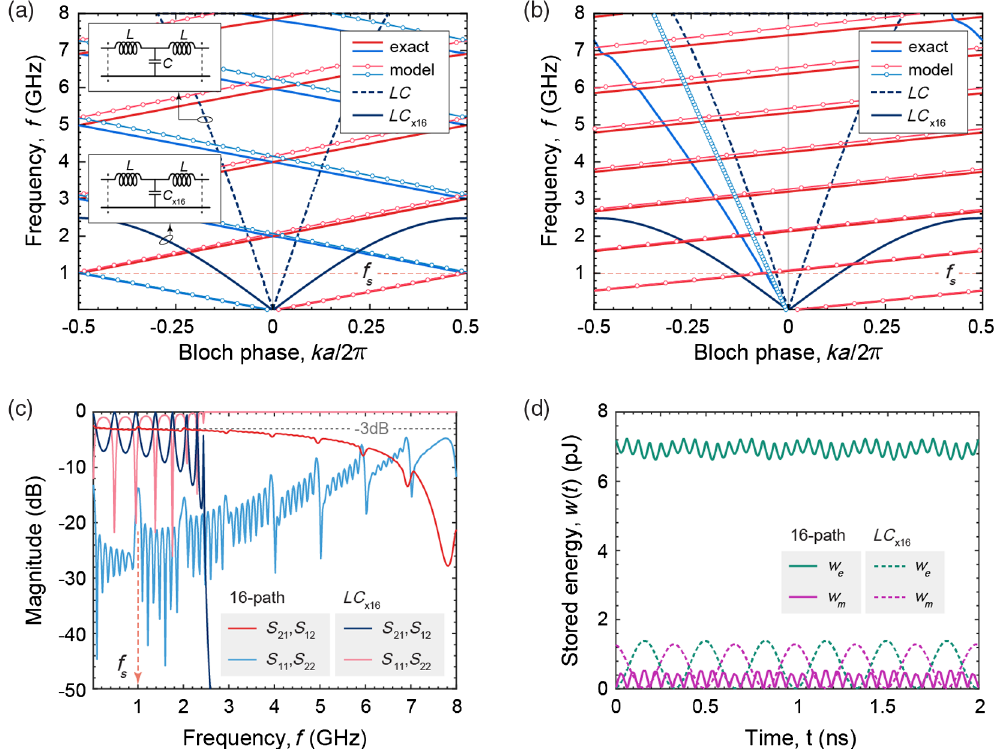
= 2 , for which the FIG. 5. (a) Band diagram of cascaded commutated networks shown in Figs. 1(d) – 1(f) computed for Δ T ¼ T s network is reciprocal at all frequencies [all other parameters are taken to be the same as in Figs. 1(d) – 1(f) with matching inductors included]. Numerical results (bold lines) are obtained using the method outlined in the Appendix. Thin lines with markers indicate an idealized nonreciprocal phase shifter response computed by means of Eqs. (4) and (5). A small discrepancy arises from the additional phase shift provided by the small inductances. Dark blue solid and dashed lines indicate Bloch phase shifts of time-invariant periodic LC ¼ 16 C , respectively. (b) The same as in (a), but for Δ T ¼ transmission lines with per-period capacitance C ¼ 0 . 68 pF and C × 16 15 T = 16 corresponding to maximum phase nonreciprocity. (c) Comparison between the scattering parameters of eight cascaded unit s cells of the commutated network and a time-invariant LC delay line. Each unit cell of the LC delay line has the same total inductance 2 L and capacitance C as the commutated network. (d) Total stored electric and magnetic energy at 1.5 GHz (steady state) in eight × 16 cascaded commutated networks (solid lines) and LC delay line (dashed lines) with equal total capacitance and